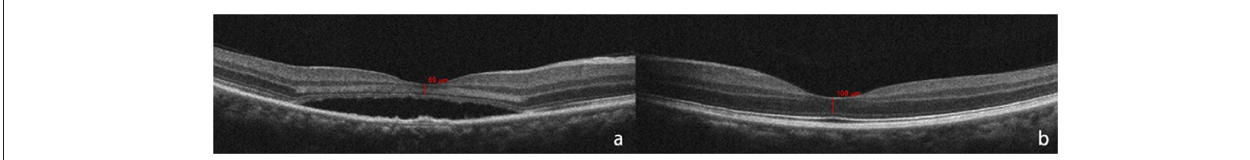
FIGURE 1 | Outer nuclear layer (ONL) thickness was calculated as the distance between internal limiting membrane (ILM), and external limiting membrane (ELM) at the fovea. The red bar shows the measurement of foveal ONL thickness (defined as the distance from ILM to ELM). Optical coherence tomography (OCT) shows SRF at fovea and thinner ONL (a) than that of the fellow healthy eye (b) at the time of the initial consultation.